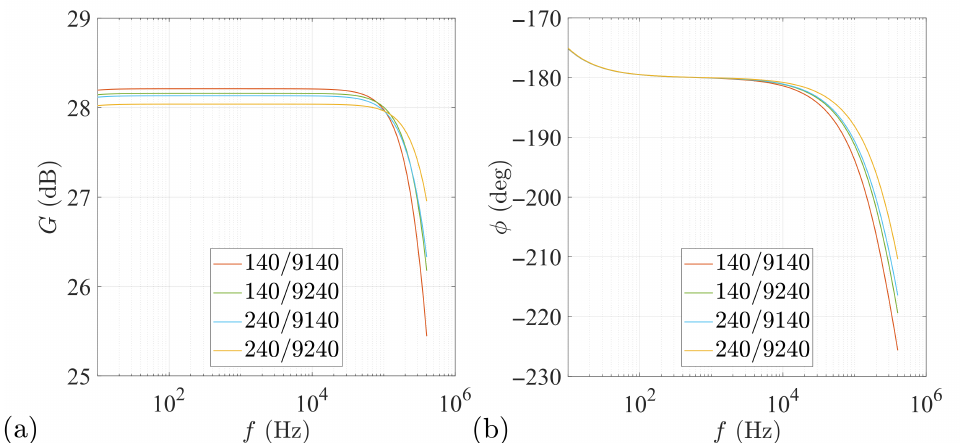
Figure 6. Numerically simulated: ( a ) amplitude; and ( b ) phase characteristic of the LF amplifier (including the pre-processing